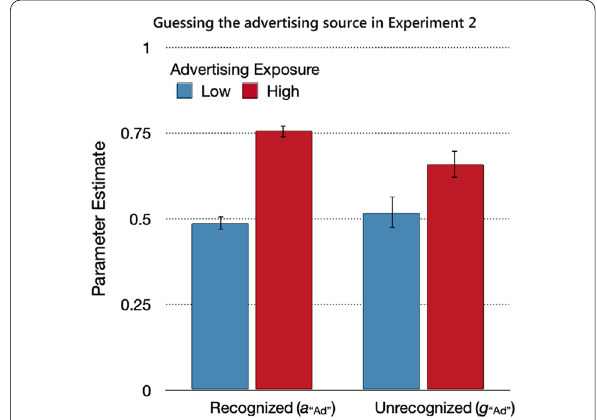
Fig. 7 Guessing the advertising source in Experiment 2. Note : Parameter estimates of the parameters reflecting the probabilities of guessing the advertising source for recognized ( a “Ad” ) and unrecognized ( g “Ad” ) statements as a function of advertising exposure (low, high). The error bars represent standard